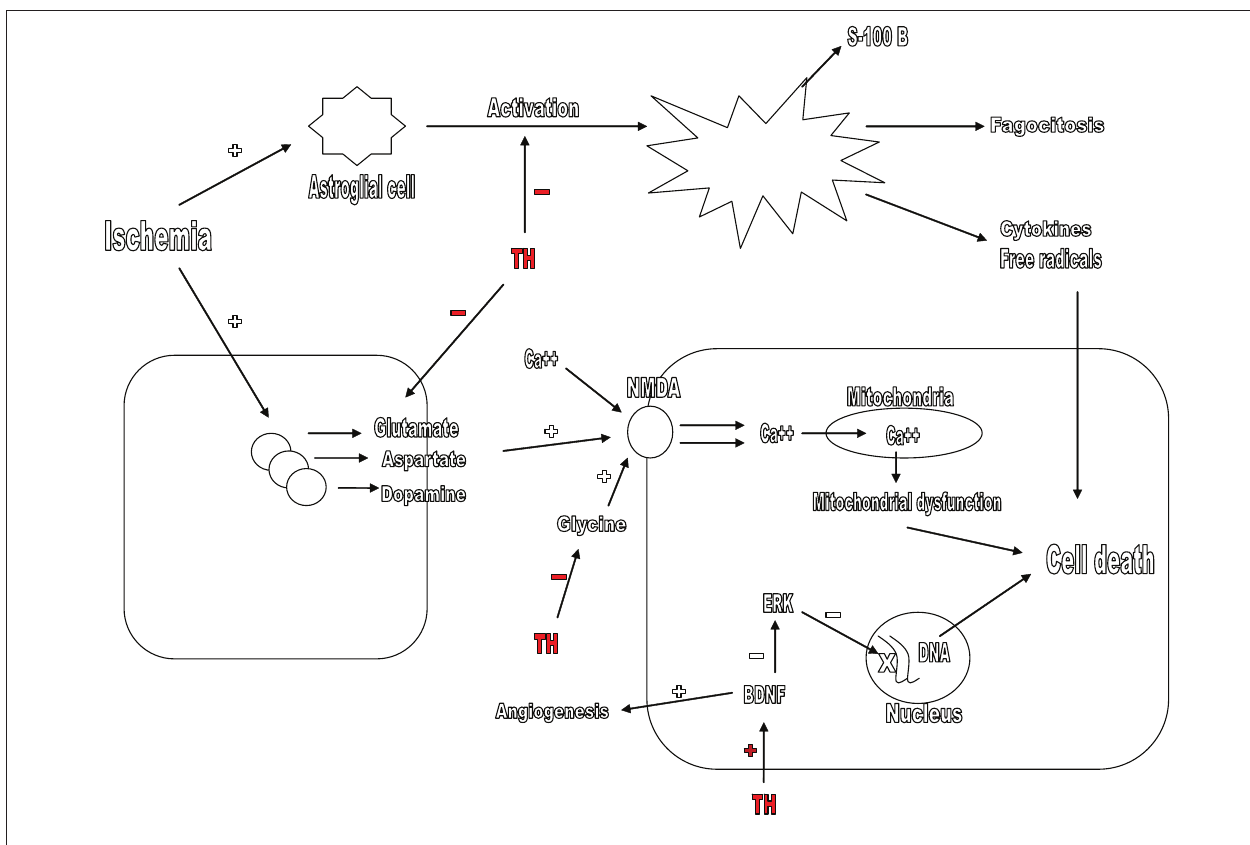
ERK pathway by stimulating the formation of BDNF. TH also avoids the transformation and activation of astroglial cells after ischemia. TH, therapeutic hypothermia; NMDA, N -methyl- d -aspartate; BDNF, brain-derived neurotrophic